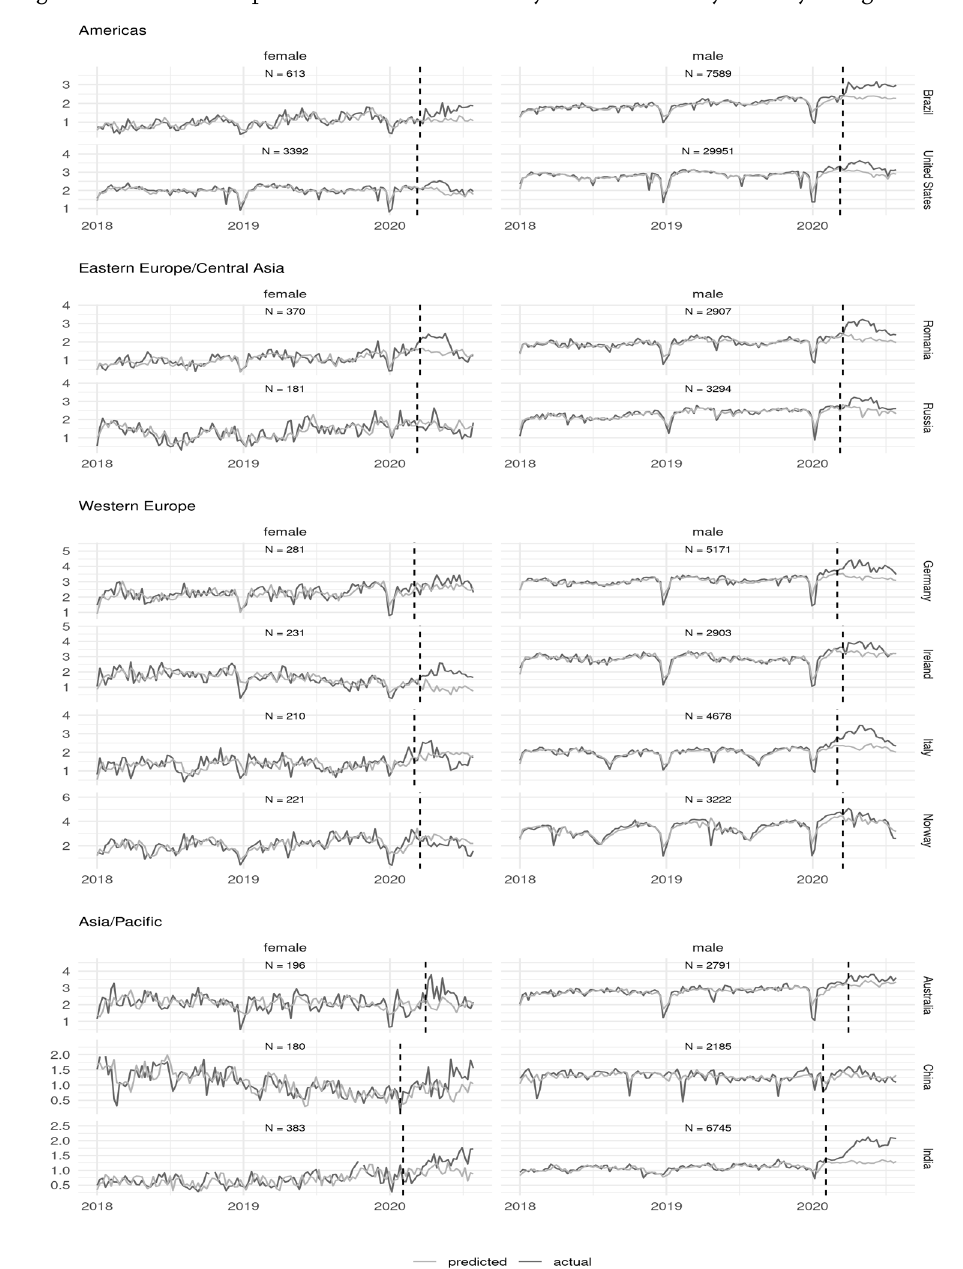
Figure 1 : Actual vs. predicted number of weekly contributions by country and